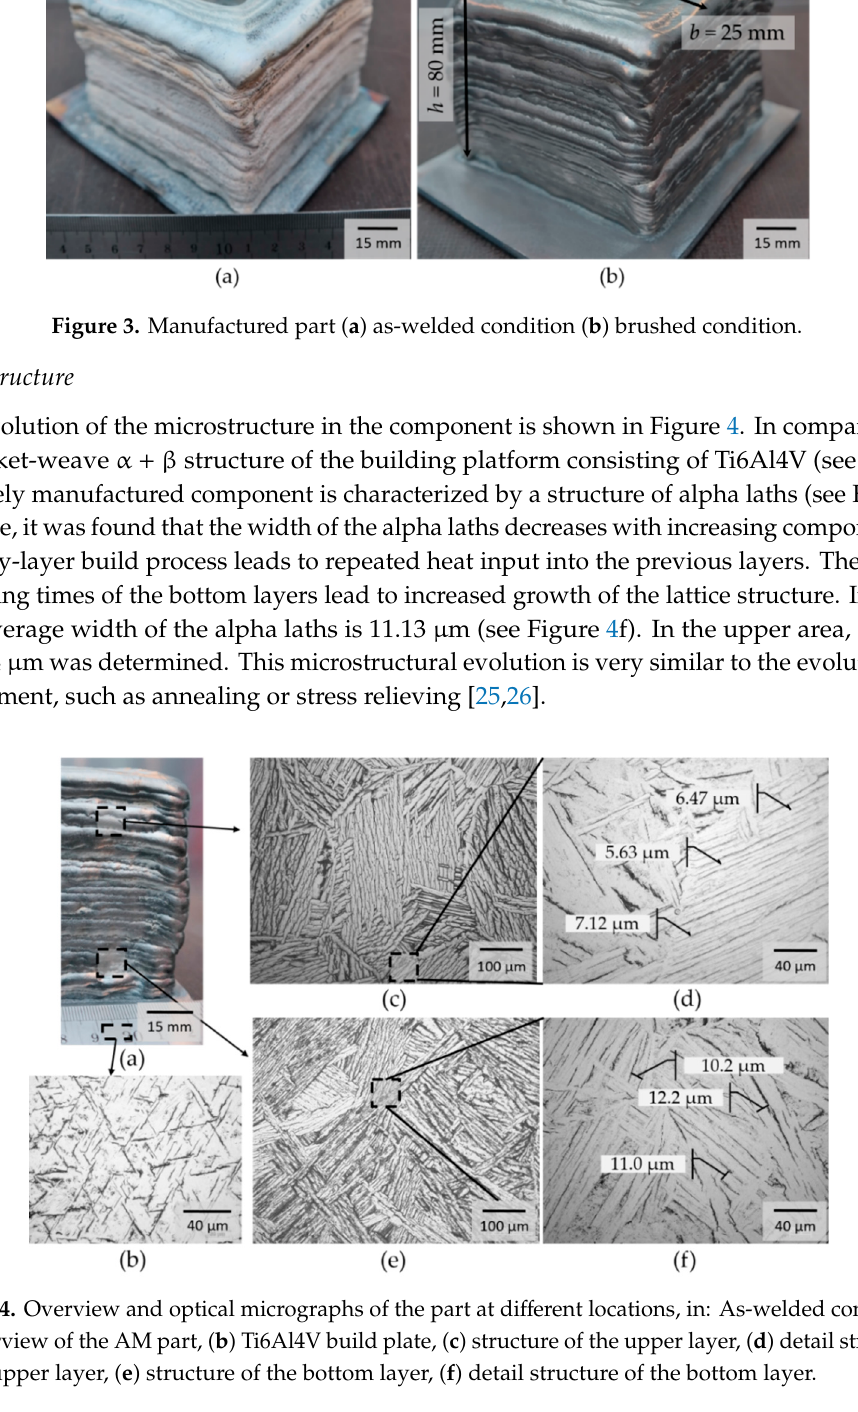
Figure 3. Manufactured part ( a ) as-welded condition ( b ) brushed condition.